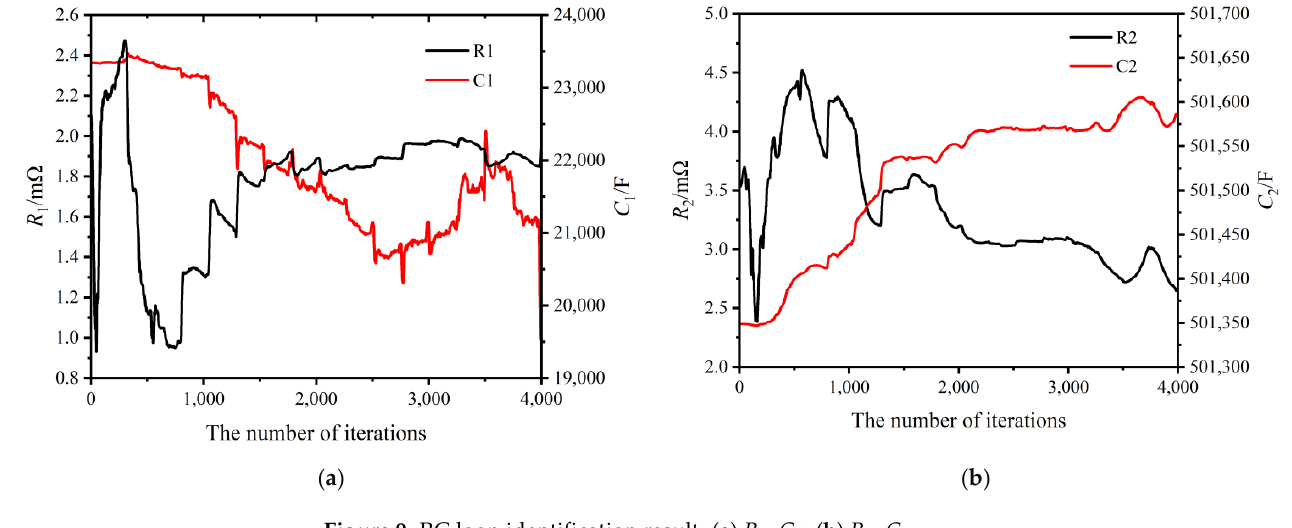
Figure 9. RC loop identification result: ( a ) R 1 , C 1 ; ( b ) R 2 , C 2